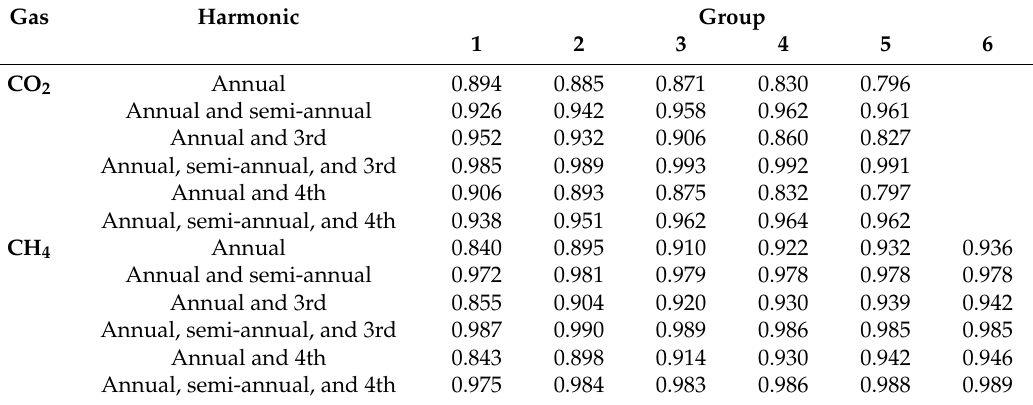
Figure 9. Monthly medians in dots and fit of Equation (3) with coe ffi cients from Table 3. Derivatives of Figure 9 . Monthly medians in dots and fit of Equation (3) with coefficients from Table 3. Derivatives these functions with respect to time are presented in light grey. of these functions with respect to time are presented in light grey. Table 2. Correlation coe ffi cients for di ff erent harmonic